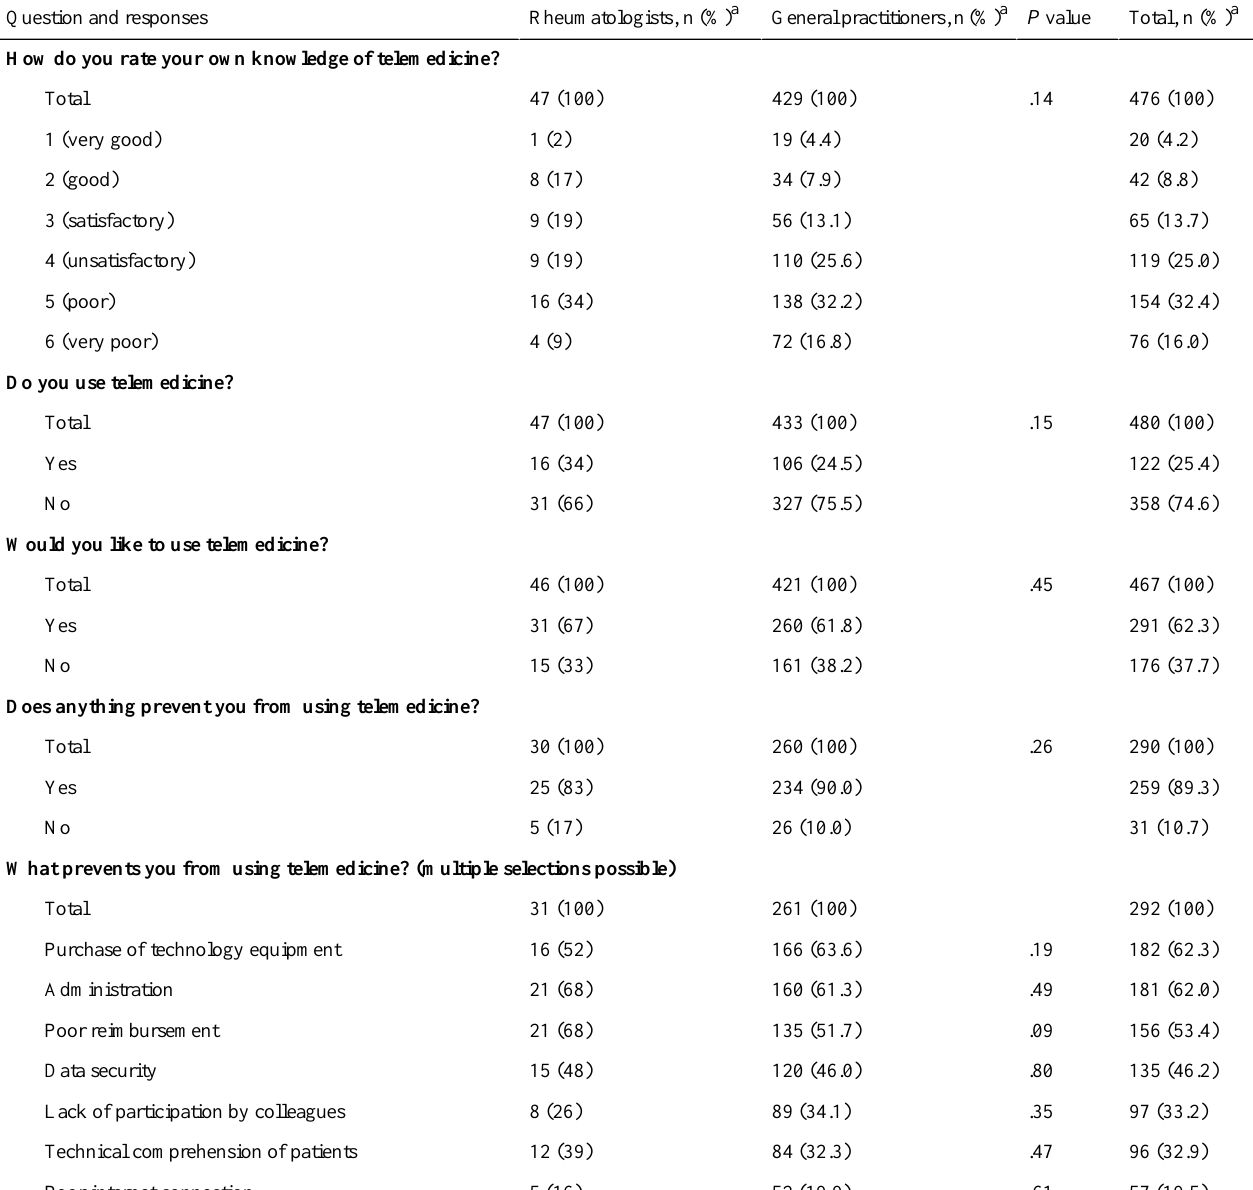
Table 2. Telemedicine: knowledge and